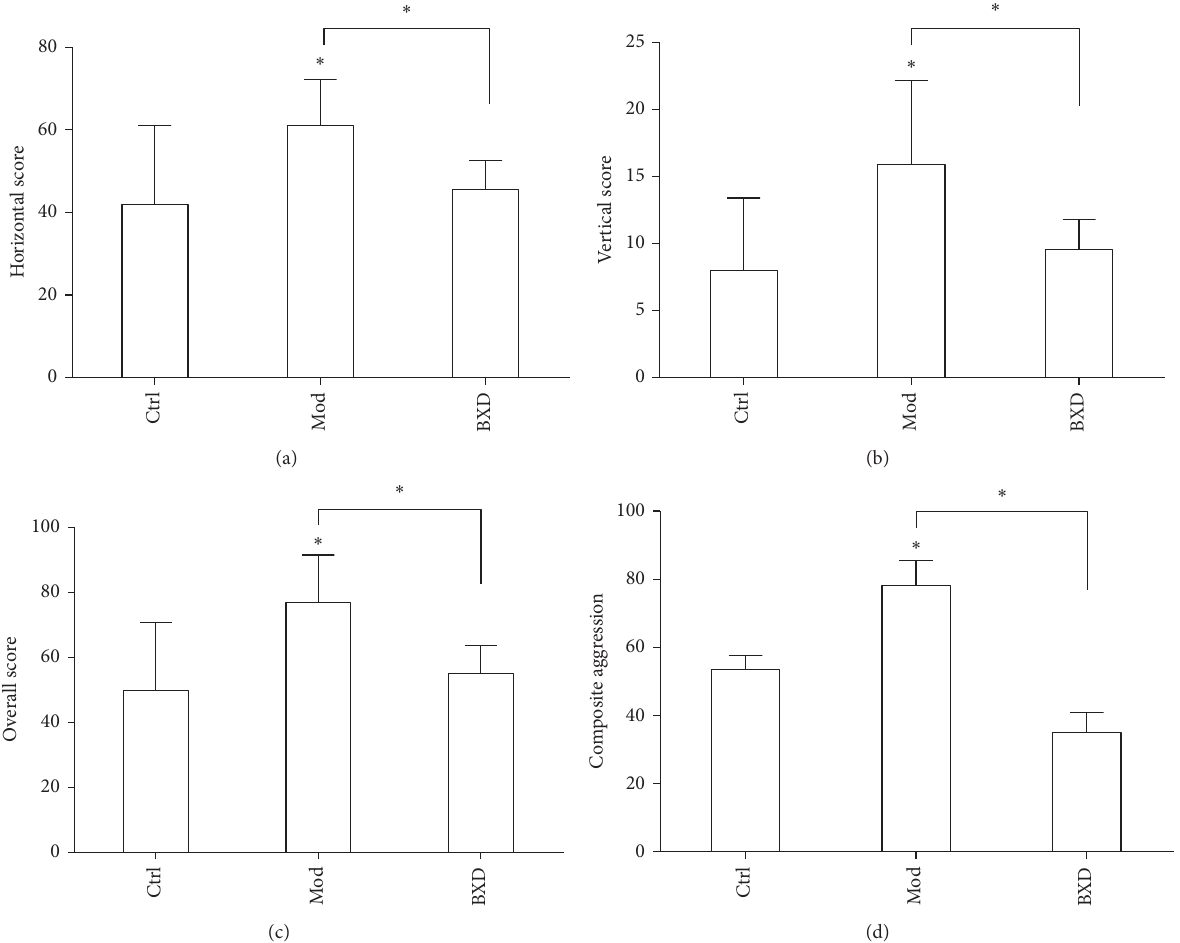
Figure 1: Behavioural assays. (a) Horizontal score in the open-field test, representing the rat’s excitability. (b) Vertical score in the open-field test, representing the rat’s exploratory behaviour. (c) Overall score in the open-field test. (d) Score in the attack behaviour test. The following groups were analysed: (1) the control/normal group (Ctrl), (2) the PMS irritability model group (Mod), and (3) the group administered with the Baixiangdan capsule (BXD). ∗ 𝑃 < 0.05 .